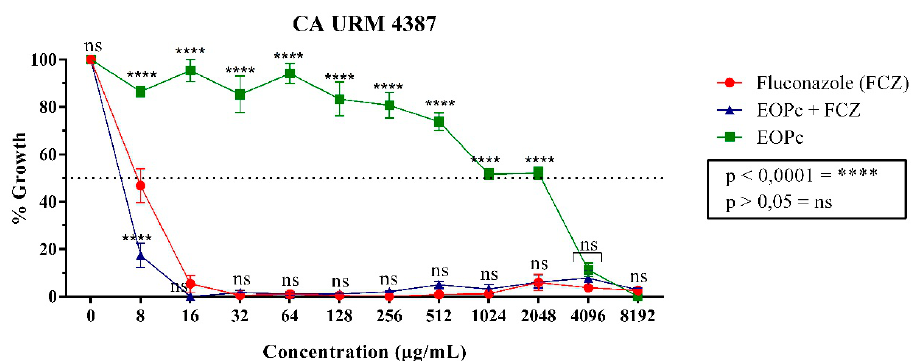
Figure 2. Anti- Candida potential of essential oil of Piper caldense (EOPc) against strains of Candida albicans URM 4387.